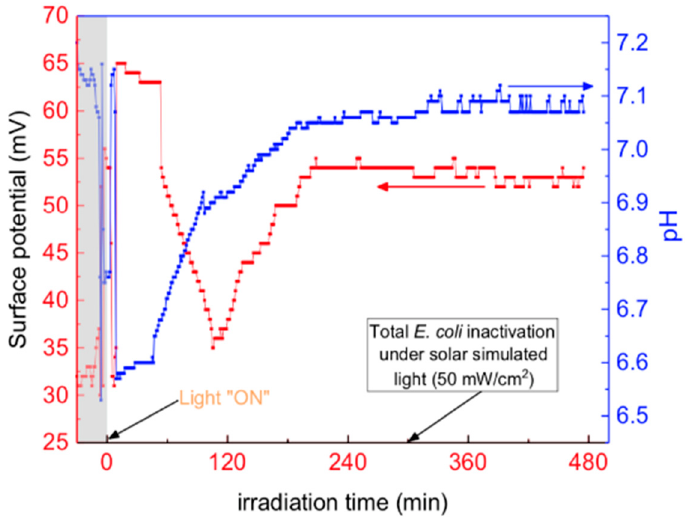
Figure 9. Interfacial potential and micro-pH during bacterial inactivation on ceramic tiles under solar simulated light operated at 50 mW/cm 2 .